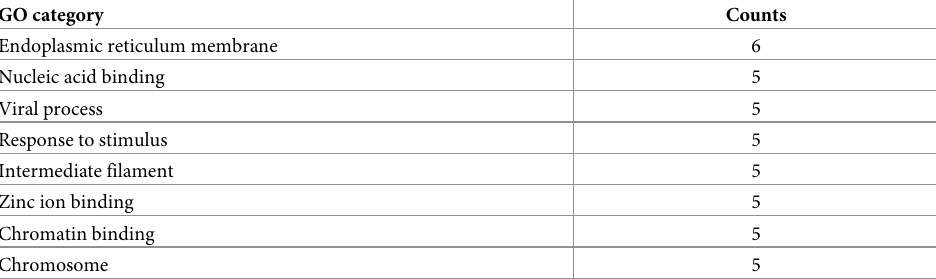
Table 6. GO category analysis. GO categories in which Z is significantly greater than 1 in at least 5 population com- parisons. Code to extract and analyse the data can be found at https://github.com/vivaksoni/test_for_balancing_